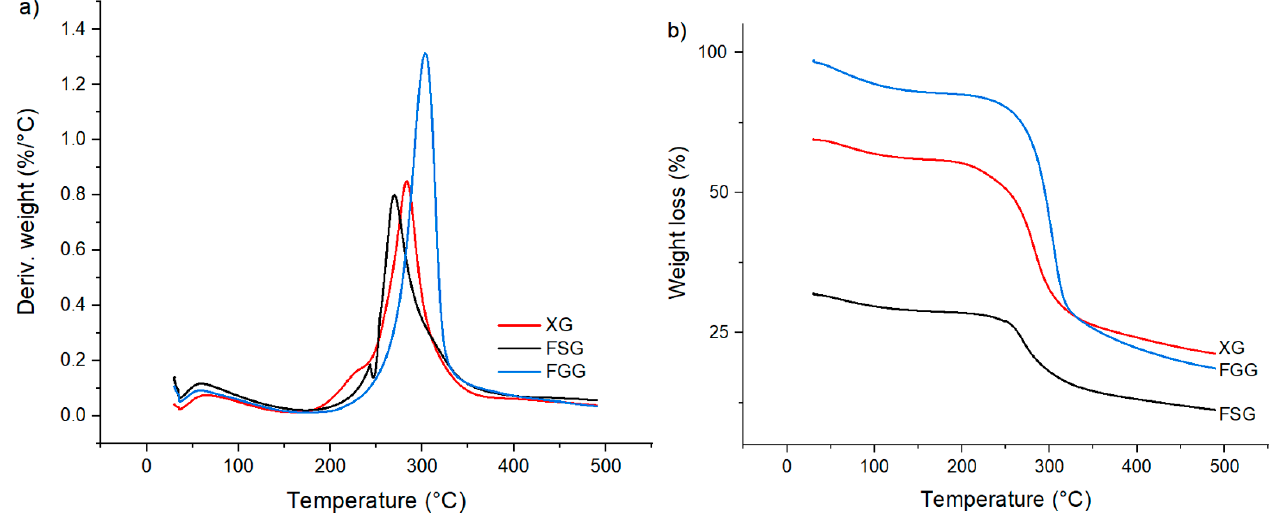
Figure 3. TGA results presented as a DTG profile ( a ) and weight loss versus temperature ( b ) for flaxseed gum (FSG), fenugreek gum (FGG) and xanthan gum